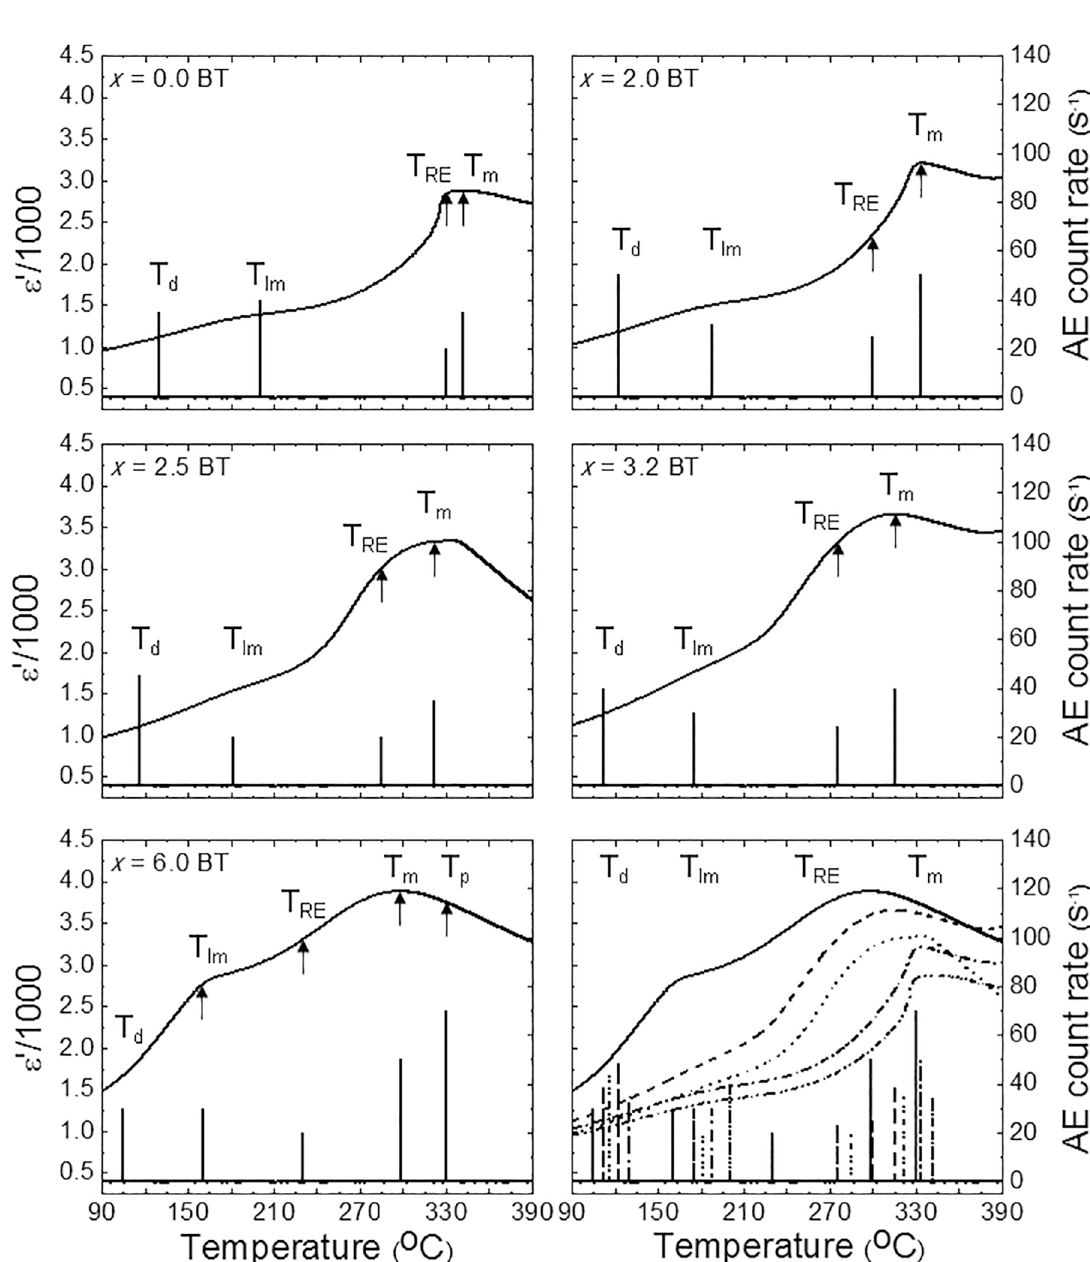
Bi TiO - x BaTiO relaxor ferroelectrics crystals (dash-dot- 0.5 0.5 3 3 , T , T , T and T in NBT- x BT crystals. d lm RE m p (s -1 )